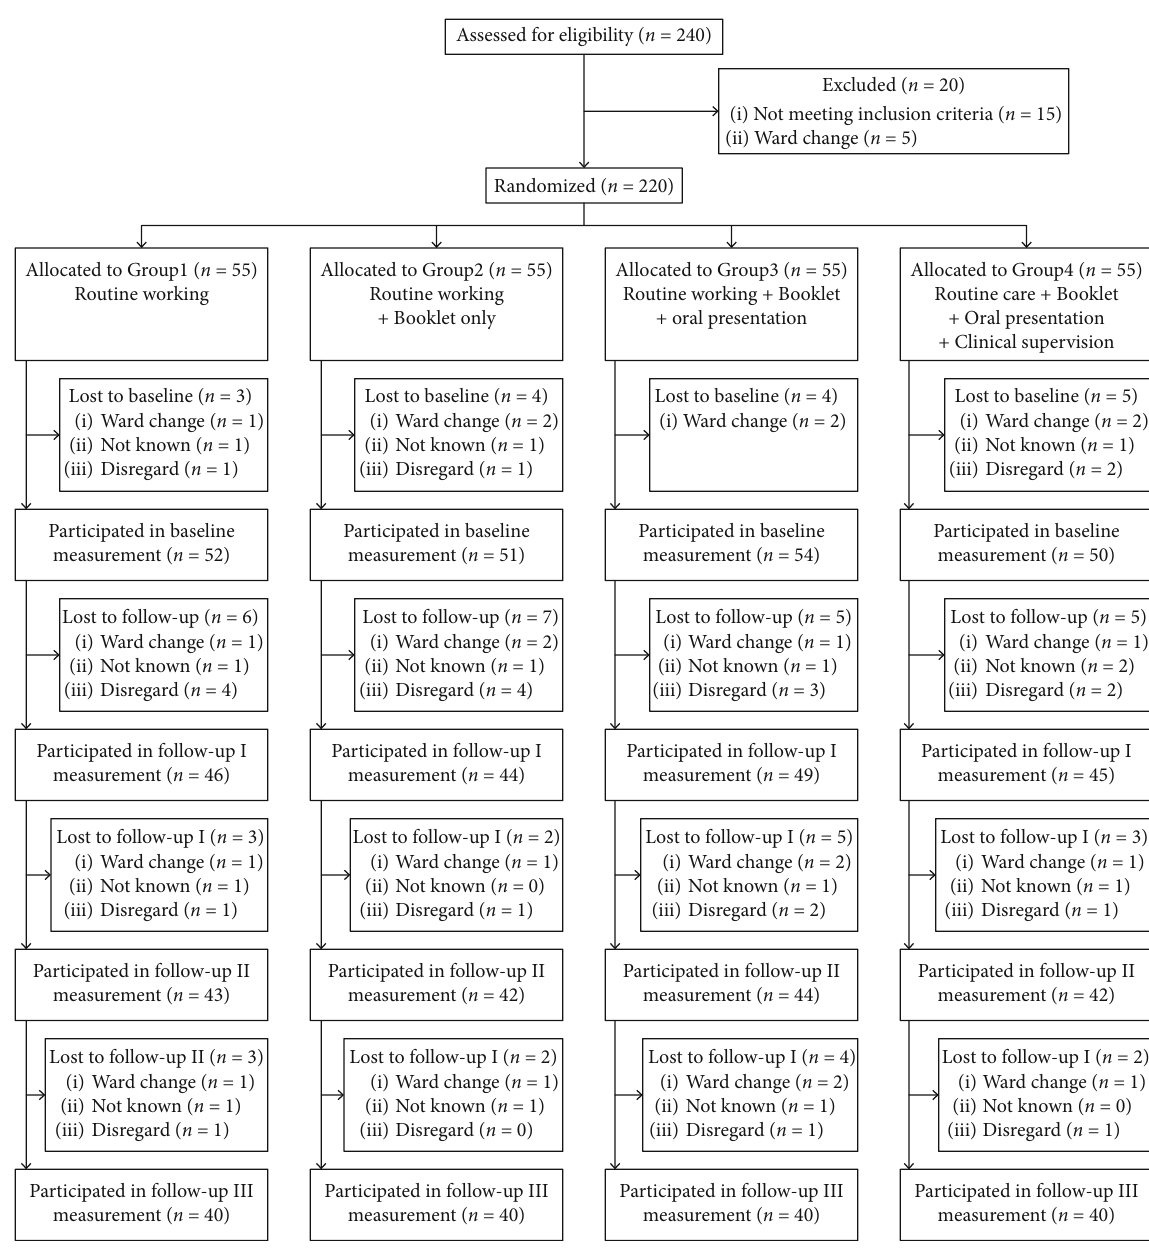
Figure 1: Flow diagram of nurse ’ s